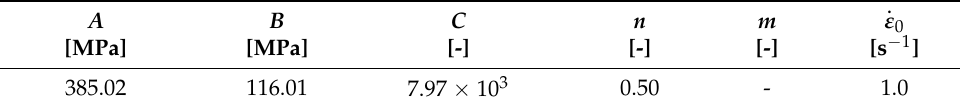
Table 3. Material parameters for the JC model for EN-AW-6082 T6 obtained from practical experi- ments.